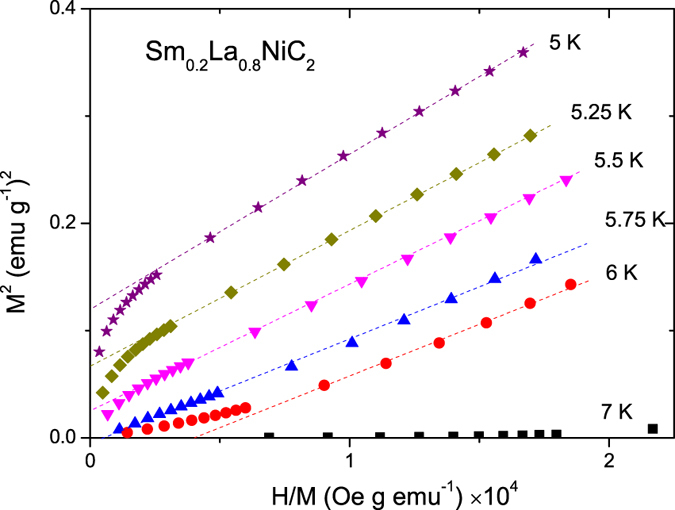
Arrott plot for Sm1−xLaxNiC2 with x = 0.8.Square of the isothermal magnetization M2 is plotted against H/M for several temperatures between 5 K and 7 K. Dashed lines are guides to the eyes.